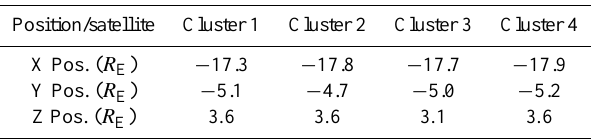
Table 1. Position of Cluster spacecraft in the GSM coordinate sys- tem at